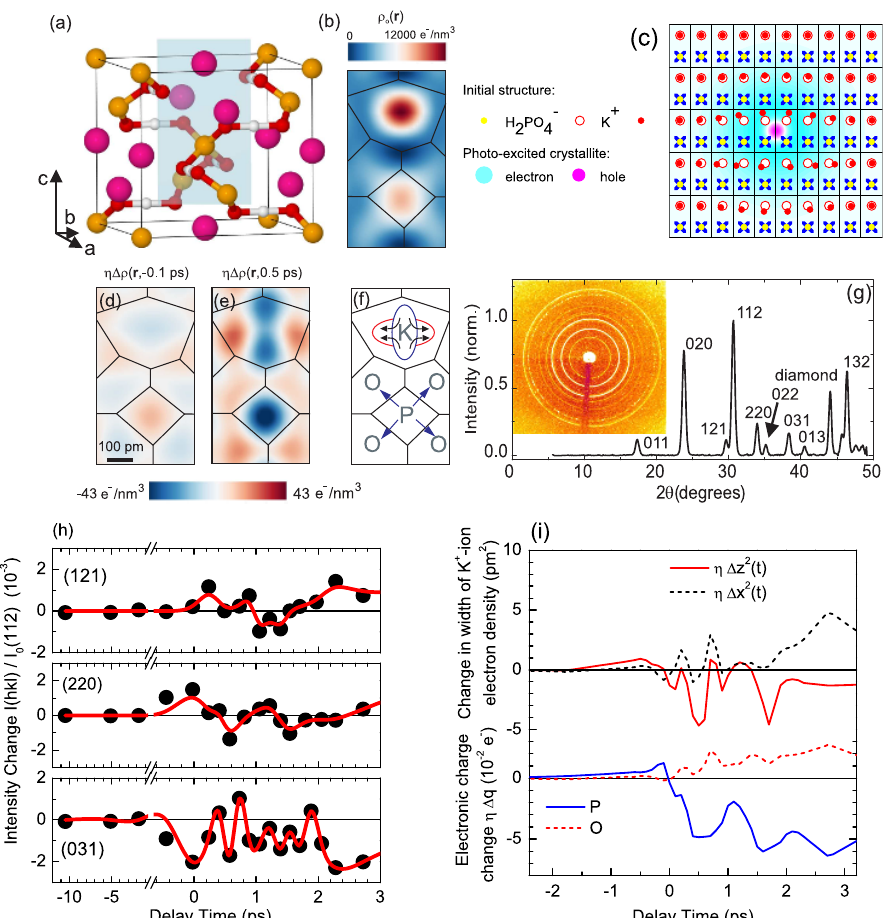
Fig. 1. (a) Unit cell of KDP in the paraelectric phase (yellow spheres: phosphorous atoms (P), pink: potassium (K), red: oxygen (O), white: hydrogen (H)). (b) Equilibrium electron density map ρ 0 ( r ) in the plane defined by the rectangle in (a). The solid lines represent the system of polyhedrons enclosing the di ff erent atoms used in data analysis. (c) Schematic of a Frenkel exciton which is generated by the optical pump pulse and extends over many unit cells. (d,e) Di ff erential charge density maps for pump-probe delays of -0.1 and + 0.5 ps as derived from the di ff raction data. (f) Positions of atoms in the plane together with a schematic view of the main features emerging from the measurements: charge transfer from P atom to the O atoms and the prolate-oblate deformation of the charge around the K atom. (g) Typical powder pattern acquired after 7 min exposure time. Inset: raw data from the CCD detector with the ring pattern. (h) Change of di ff racted intensity on three selected reflections as a function of the delay between optical pump pulse and the x-ray probe. (i) Upper panel: Transient quadrupolar distortion of the electron density of the K + ion: the broadening along the c-axis η∆ z 2 ( t ) and along the a / b axis η∆ x 2 ( t )